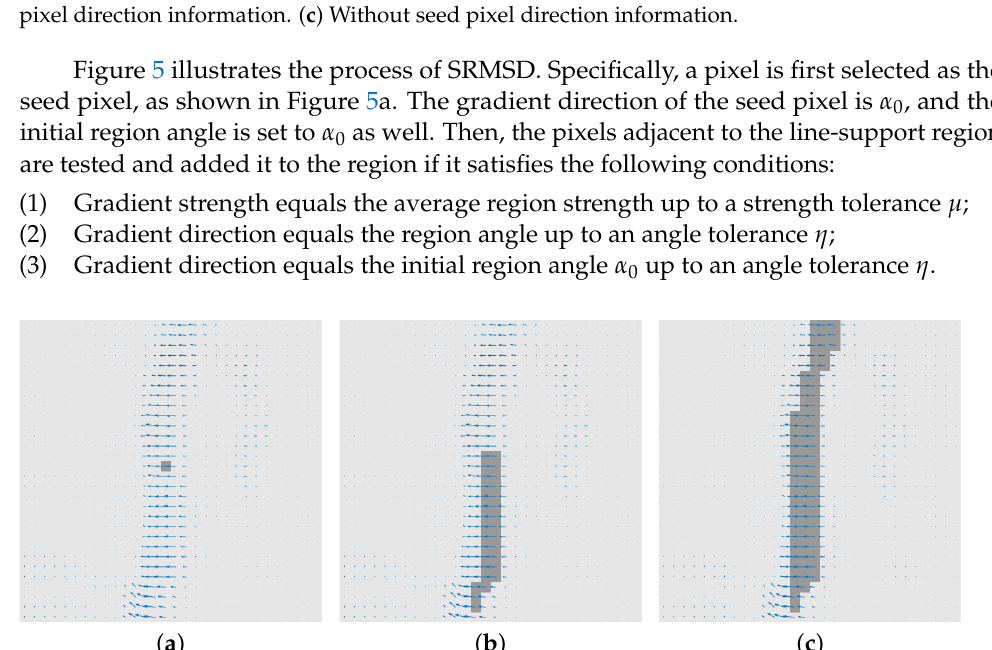
Figure 4. Effect of the seed pixel direction. ( a ) Scenes with slow directional changes. ( b ) With seed pixel direction information. ( c ) Without seed pixel direction information.